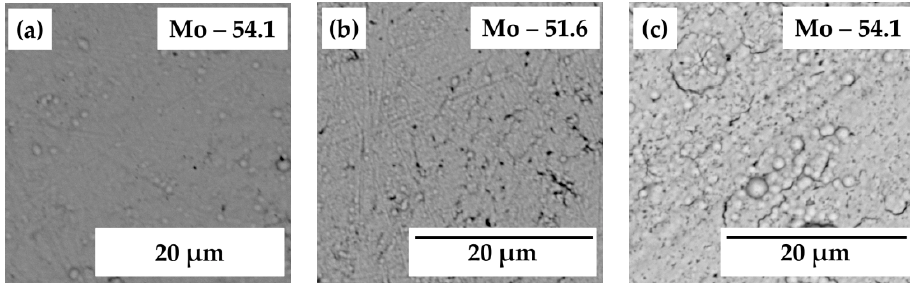
Figure 1. SEM images of electrodeposited at 30 mA/cm 2 and [Me(II)]/[MoO 42 − ] = 0.5 coatings: Ni–Mo ( a ), Co–Mo ( b ) and Fe–Mo ( c ). The time of electrolysis was 1 h and the thickness of all deposits was ∼ 10 µm.